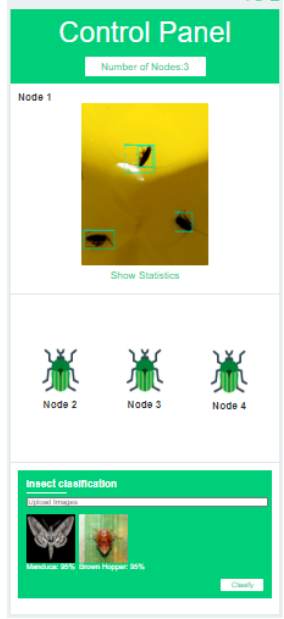
Figure 3. Overview of android mobile